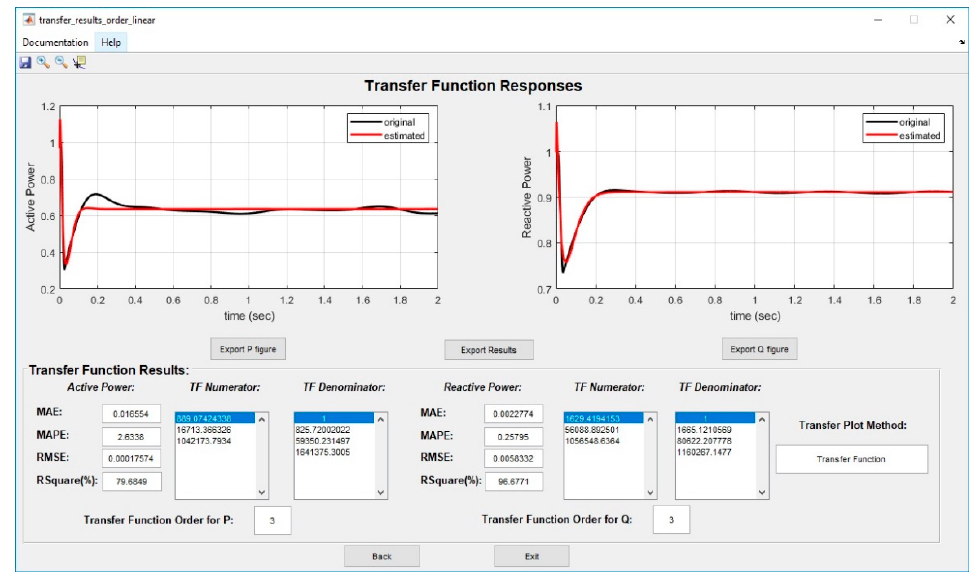
Figure 8. Equivalent model result window. Indicative results for unique input signal and specified transfer functions (TF) order.